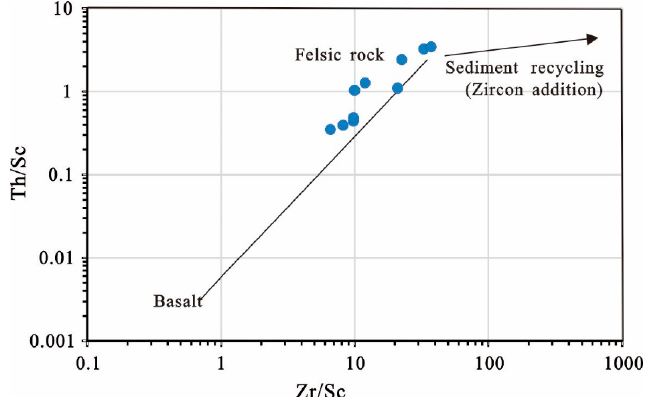
Figure 18. Plot of Th/Sc versus Zr/Sc for the coal bench, partings, and host rock samples from Dongpo Mine. Minerals 2019 , 9 , 402